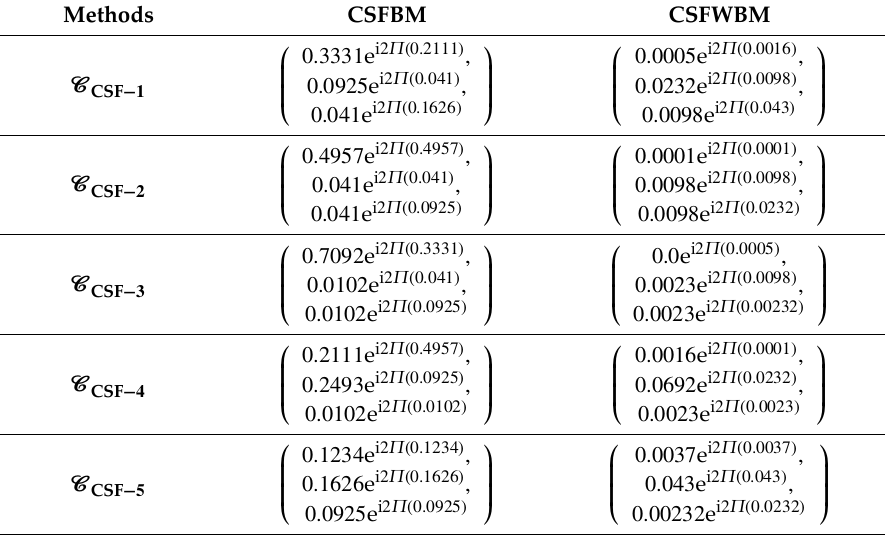
Table 2. Aggregated values by using Equations (8) and